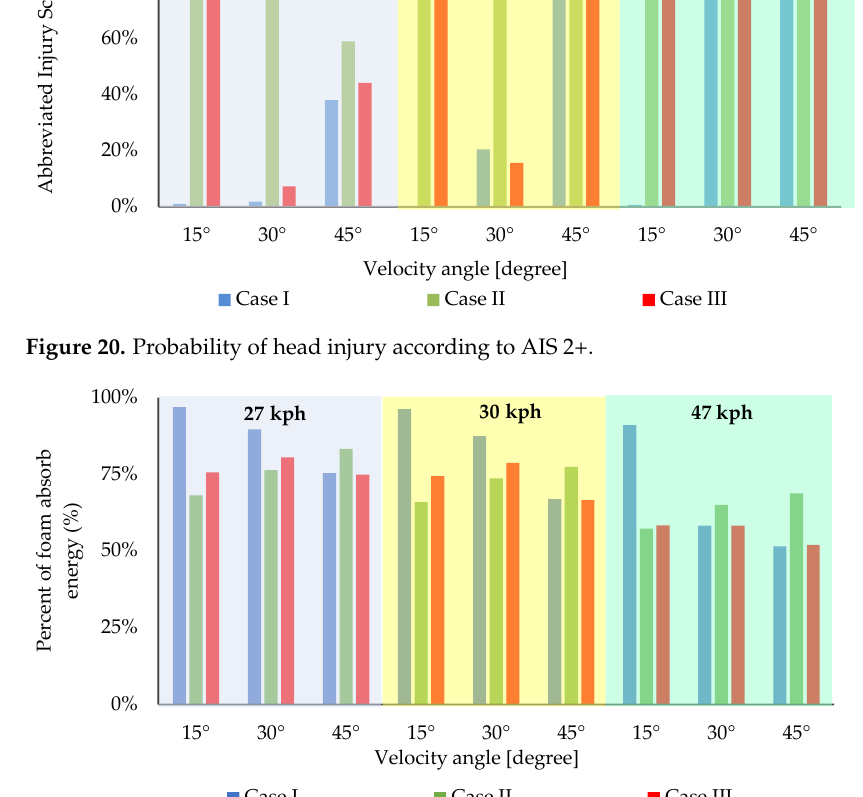
Figure 20. Probability of head injury according to AIS 2+.